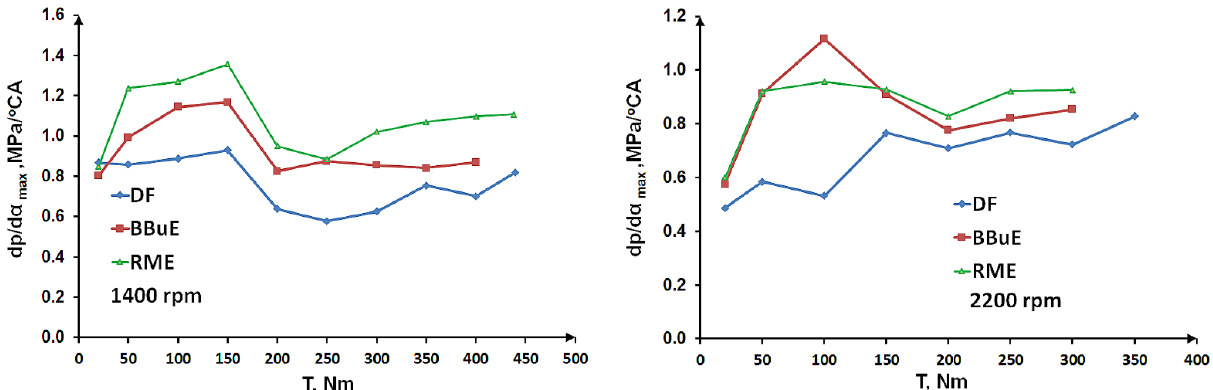
Figure 8. Maximum values of the degree of pressure increase (dp/d α )max during the combustion